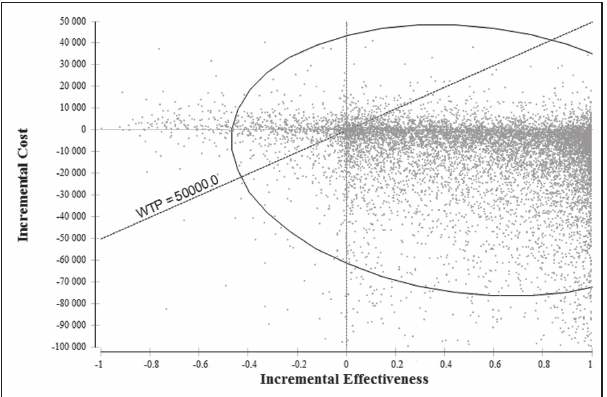
Figure 4) Incremental cost-effectiveness scatter plot of initial partially cov- ered self-expandable metal stent (SEMS) versus initial polyethylene stent (PES). All costs expressed in 2014 United States dollars. The willingness- to-pay (WTP) threshold (US$50,000) is the line that intersects the origin and the initial PES strategy is represented by the origin (0;0)